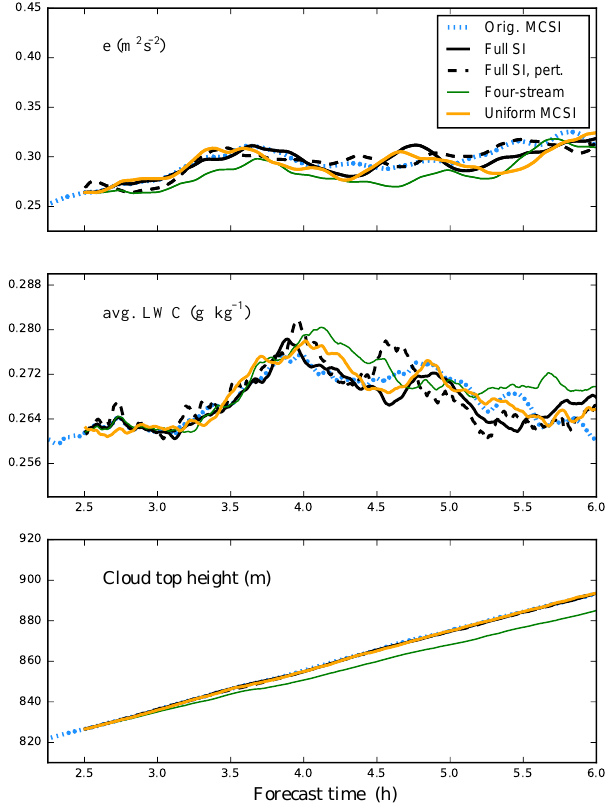
Figure 1. Intercomparison of the DYCOMS-II simulation, once forced with the full radiation (solid line), with the original Monte Carlo spectral integration (dotted) and with the uniform ver- sion (dashed). The dash-dotted line is a calculation with full spectral integration but with the four-stream solver instead of the two-stream solver. The top panel displays the vertically integrated turbulent ki- netic energy, the middle panel displays the mean liquid water con- tent (conditionally sampled and weighted by physical height), and the bottom panel displays the mean cloud top